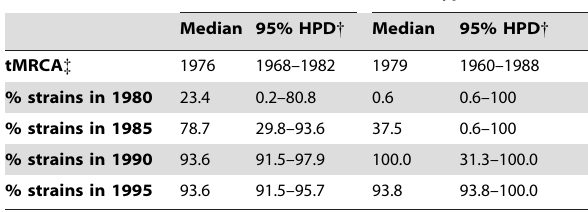
Table 1. Bayesian estimates of median time to the most recent common ancestor, and median proportions of current lineages existing at the studied time-points.